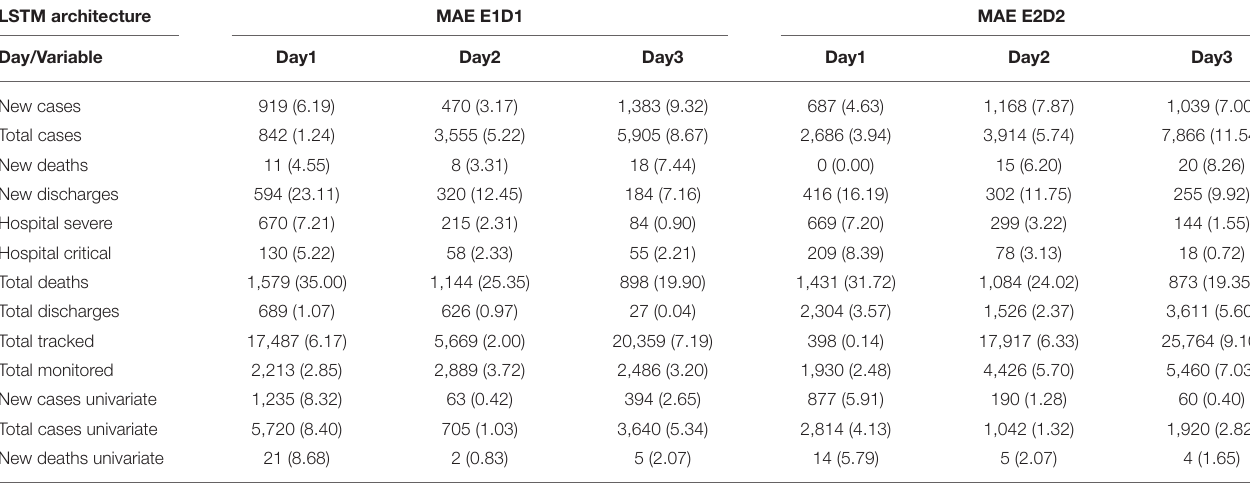
TABLE 1 | Multivariate and Univariate Model Performance Comparison Between Different LSTM Architectures based on Mean Absolute Error (MAE). LSTM architecture MAE E1D1 MAE